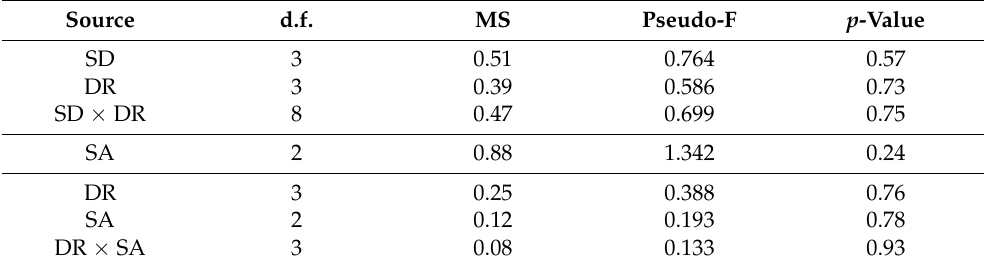
Figure 6. Average density (+ S.E. as vertical bar) of Cassiopea andromeda individuals for each size Table 1. Results of the PERMANOVA on the average density of each size class: per sampling date class per depth range. (SD) and depth range (DR), per sub-area (SA), and per depth range and sub-area.